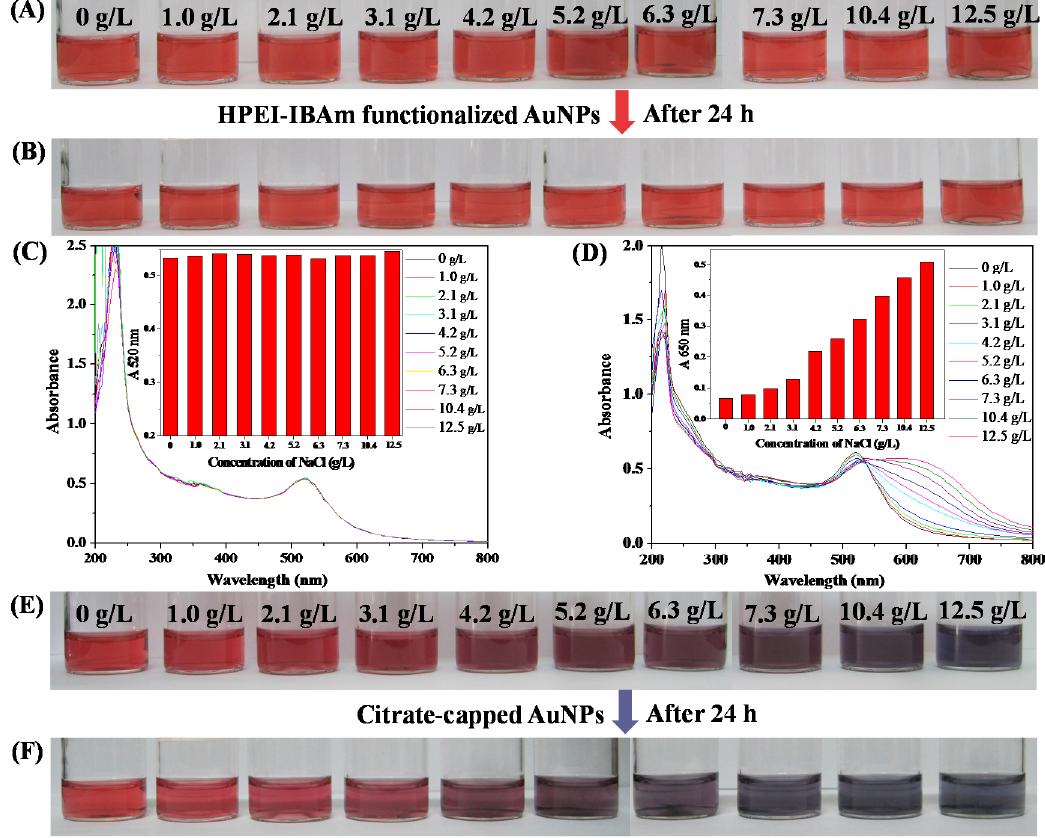
Figure 5. Photographs of the HPEI-IBAm functionalized AuNPs ( A ) before and ( B ) after 24 h under different salt concentrations; the UV-Vis spectra ( C ) of the HPEI-IBAm functionalized AuNPs after 24 h under different salt concentrations (Inset shows the A 520 value of the absorbance at 520 nm versus the concentration of NaCl); the UV-Vis spectra ( D ) of the citrate-capped AuNPs under different salt concentrations (inset shows the A 650 value of the absorbance at 650 nm versus the concentration of NaCl); photographs of the citrate-capped AuNPs ( E ) before and ( F ) after 24 h under different salt concentrations.